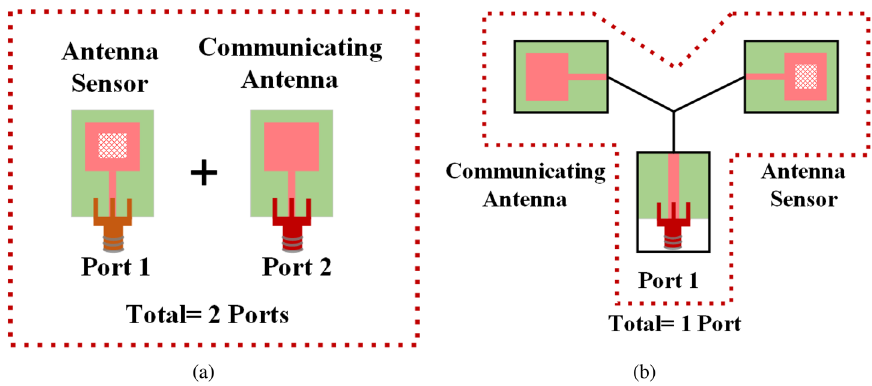
Figure 1. ( a ) Separate antenna and antenna sensor on a substrate requiring two different ports, vs ( b ) our proposed design with a single port.